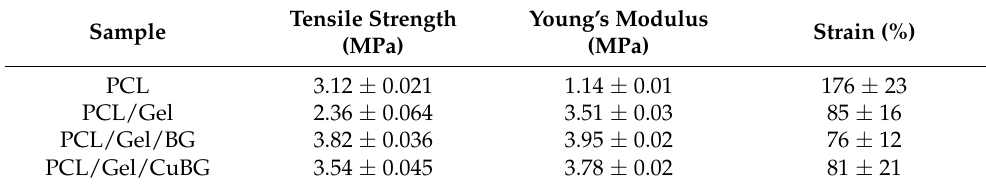
Table 4. Mechanical properties of PCl, PCl/Gel, PCl/Gel/BG and PCl/Gel/CuBG Scaffolds.